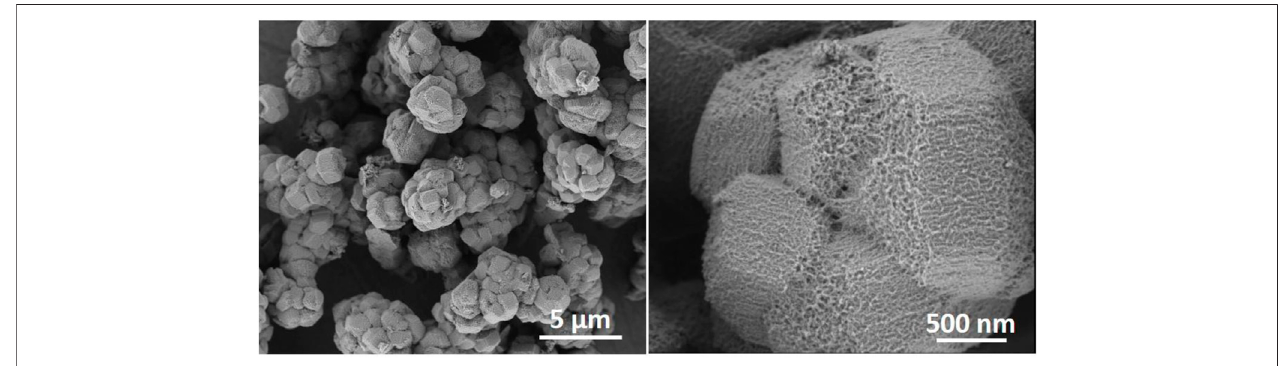
FIGURE 6 | HR-SEM images of zeotile-4synthesized using Pluronic P104 as mesostructuring agent, material from the same family that is discussed in Pulinthanathu Sree et al. (2012) and Pulinthanathu Sree et al. (2017).